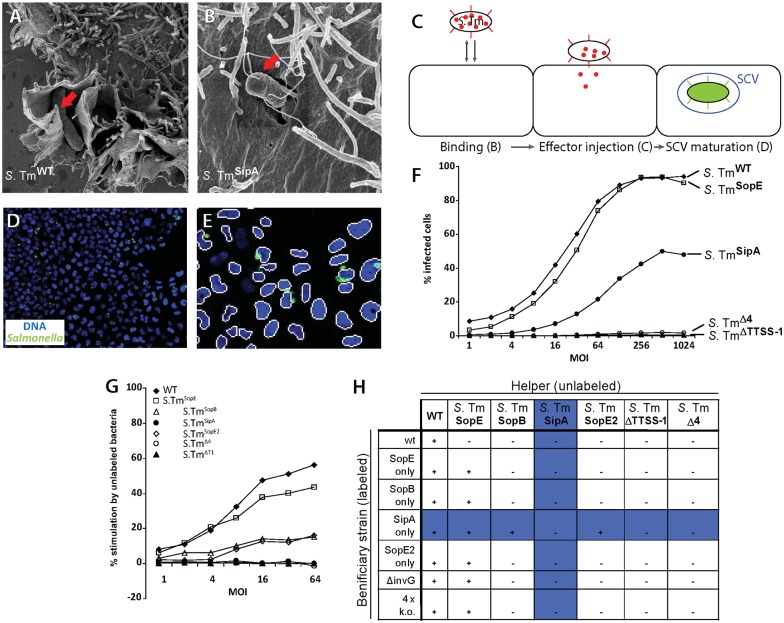
(A and B) Scanning electron micrographs of wild type (A) and S. TmSipA strains (B) infecting HeLa cells. (C) Representation of Salmonella Typhimurium infection steps (adapted from [31]). (D) Representative image of the genome-wide RNAi screen, (E) spot- and nuclei-detection of the infectX pipeline (right) at MOI150. (F) HeLa Kyoto cells were infected at increasing MOI using different SPI-1 effector mutant strains (Table 1) and the infection efficiency infection was monitored using the modified gentamicin protection assay. (G) Helper assay using different T1 effector mutants in HeLa cells. (H) Representation of helper activity of different T1 effector mutants.